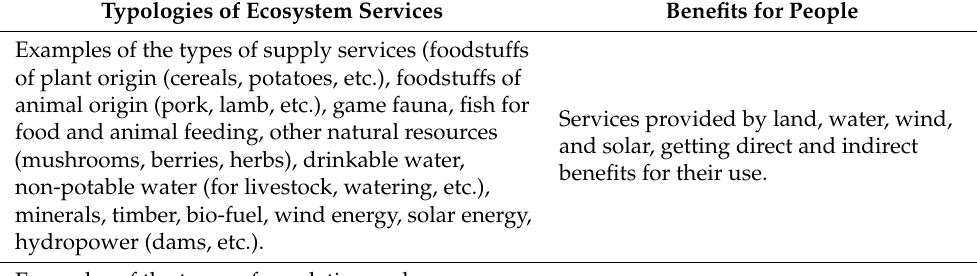
Table 1. Typologies of ecosystem services [28] and their benefits. Typologies of Ecosystem Services Benefits for